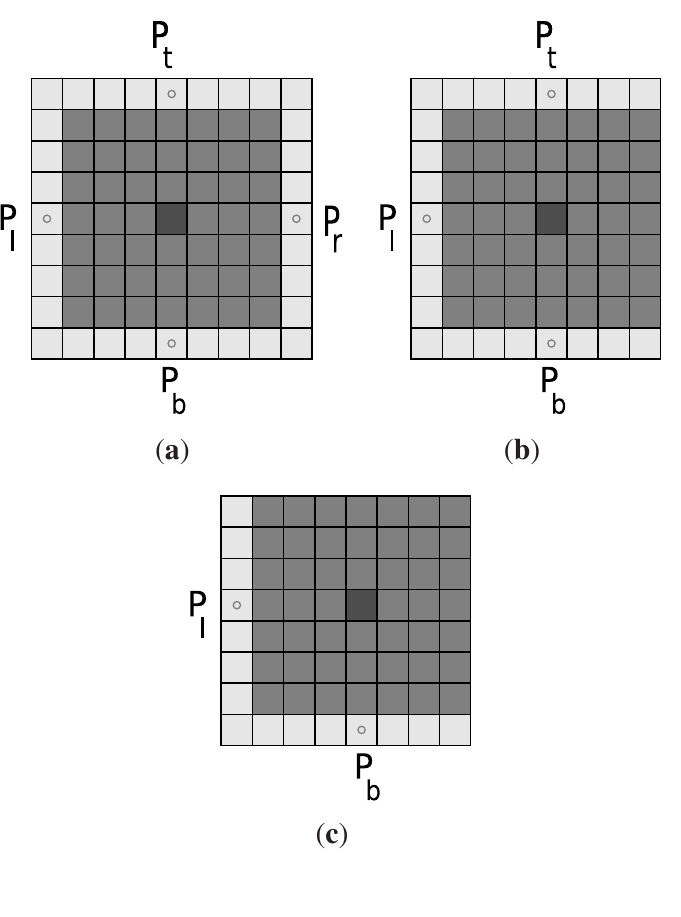
Figure 4. Locating valid DTM locations when repairing bad regions in a DTM: (a) the case when the bad region is completely embedded into the DTM and all of the required points , P , P , and P ( P ) exist; (b) the case when the bad region lies on the border of the DTM and t r b l one of the required points is missing; (c) the case when the bad region lies on the corner of the DTM and either of the pair of the required points { P is missing. The darkest square at the center represents the DTM location, which is currently being estimated within a bad region (the darker squares); the light squares bordering the bad region represent valid DTM locations used for